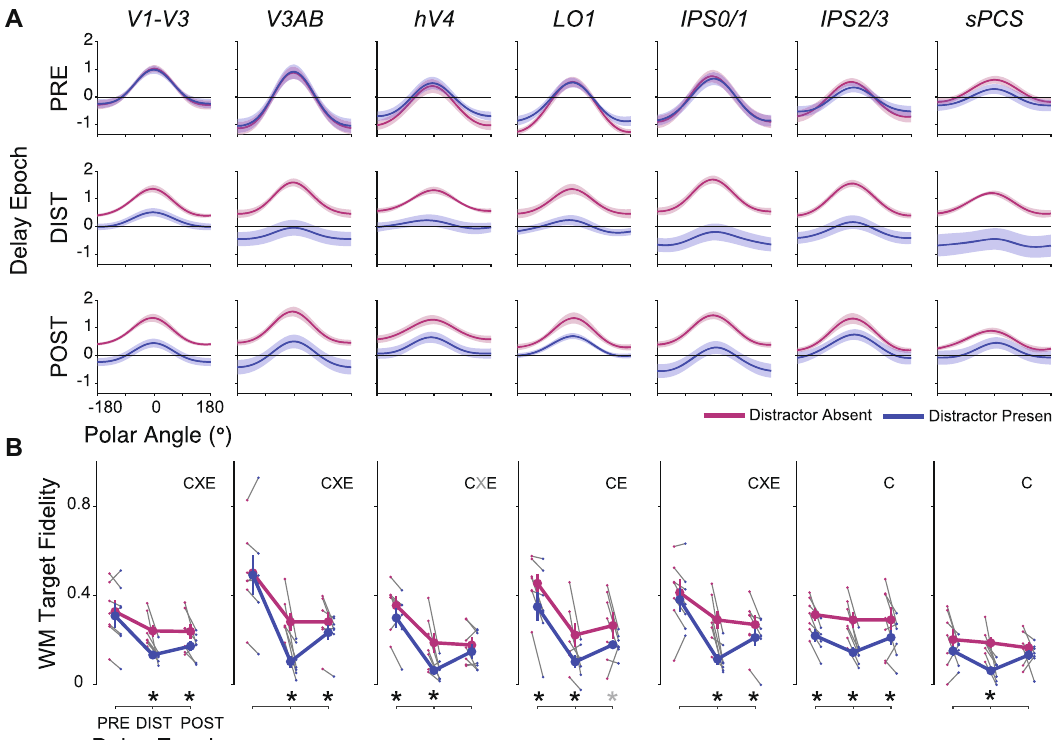
Fig. 5 WM representations are transiently disrupted by an attended distractor. A Independently trained model-based reconstructions of the WM target locations on distractor-absent (magenta) and distractor-present trials (blue) each averaged over three epochs of the memory delay. The epochs were composed of TRs before the distractor (3.75 – 5.25 s), during the distractor (8.25 – 9.75 s), and after the distractor (10.5 – 12 s), accounting for the hemodynamic delay. Error bars ±SEM. Changes in the baseline (vertical offset) of these reconstructions, which may be due to differences in mean univariate BOLD activation, do not impact fi delity computations (Fig. 5B). Note that during the distractor epoch, the reconstructions of the WM target locations appear weaker on distractor-present compared to distractor-absent trials. In some regions, this effect of the distractor lasts into the post- distractor epoch. B Group mean (error bars, ±SEM) fi delity of reconstructed WM targets on distractor-absent (magenta) and distractor-present (blue) trials separately for the pre-distraction, distraction, and post-distraction epochs. Thin gray lines connect mean distractor-absent (small magenta dots) and distractor-present (small blue dots) fi delity for individual participants ( n = 7) for each delay epoch. The results from 2-way ANOVAs for each ROI (epoch and condition as factors; compared against a shuf fl ed null) are marked by symbols to denote the signi fi cant main effects of condition (C), epoch (E), and the interaction between epoch and condition (X). The signi fi cant results of paired (two-tailed) t -tests between distractor-present and distractor-absent reconstructions per epoch, for each ROI, are marked with asterisks. In both cases, gray symbols denote p < 0.05, uncorrected, and black p < 0.05, FDR corrected across ROIs within-test. Results for individual ROIs shown in Supplementary Fig. 4, and all p -values available in Supplementary Table model estimated using shuf fl ed trial labels; FDR corrected within each ROI).